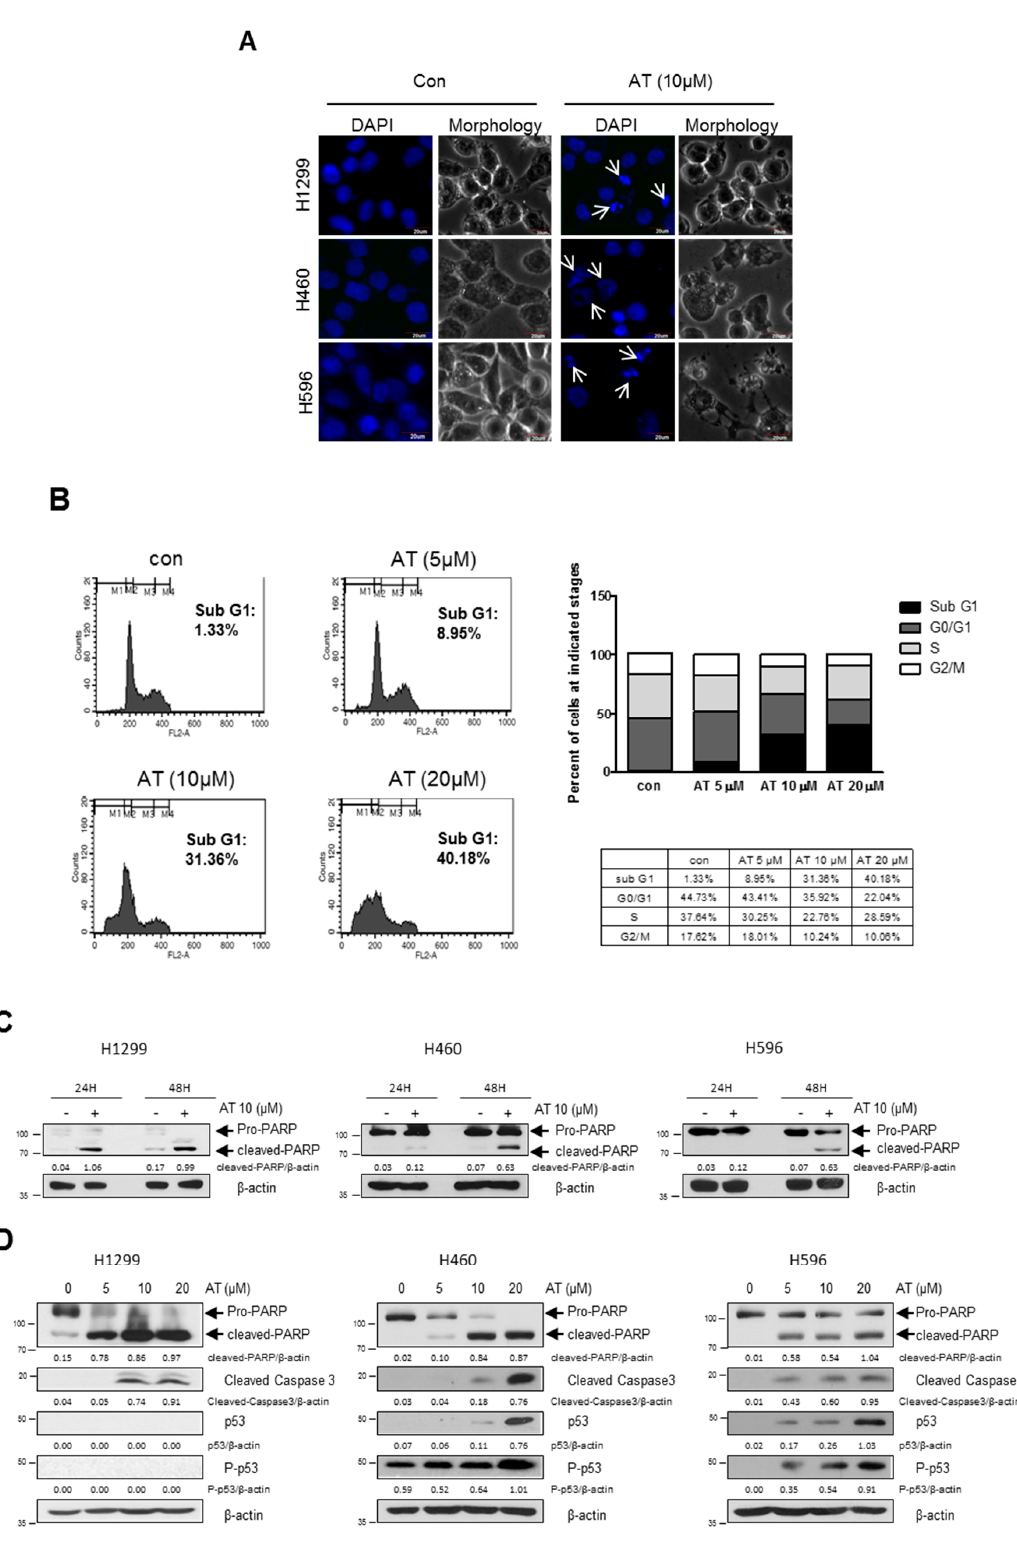
Figure 2. Cont Figure 2. Cont.